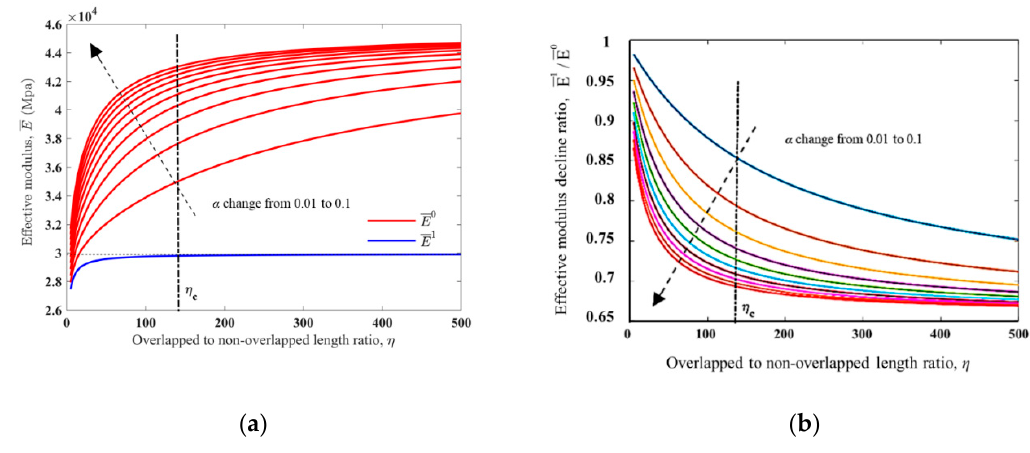
Figure 4. ( a ) The effective modulus of the unit cell at “phase 0” and “phase 1” and ( b ) the effective modulus decline ratio with respect to the non-dimensional geometrical parameter η and the non-dimensional material parameter α . In both ( a ) and ( b ), α changed from 0.01 to 0.1 discretely, as shown by the black dashed line. η were set from 5 to 500 continuously; the η c was marked with the black dash-dotted line.